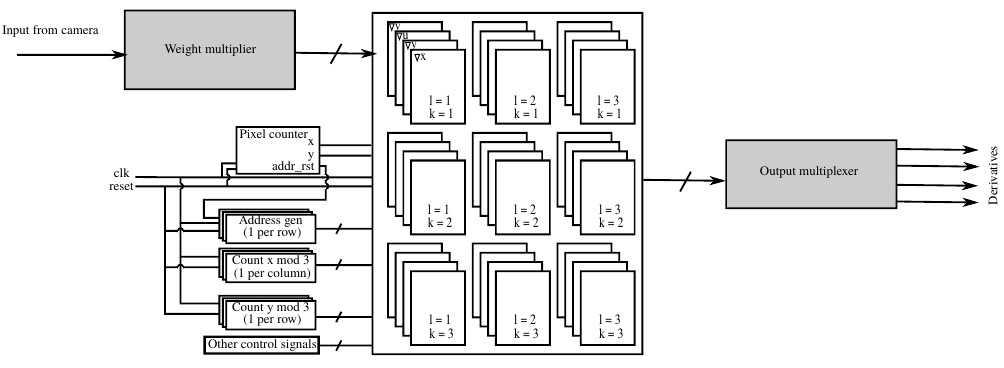
Figure 9. Schematic diagram of grid